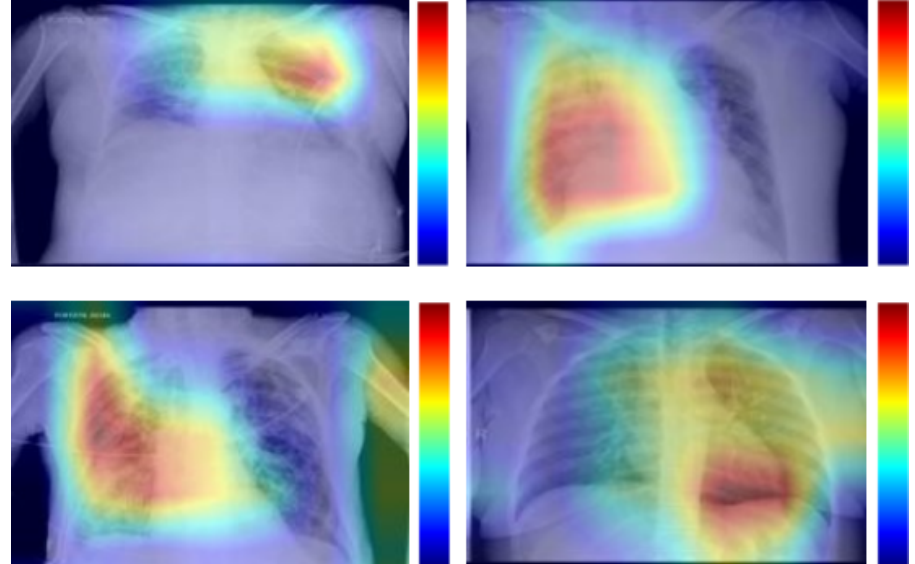
Figure 1. Results of the proposed methodology for the analysis of separability of COVID-19 and pneumonia-infected lungs in chest X-ray images. 1st row, chest X-ray images from patients infected with pneumonia. 2nd row, chest X-ray images from patients infected with